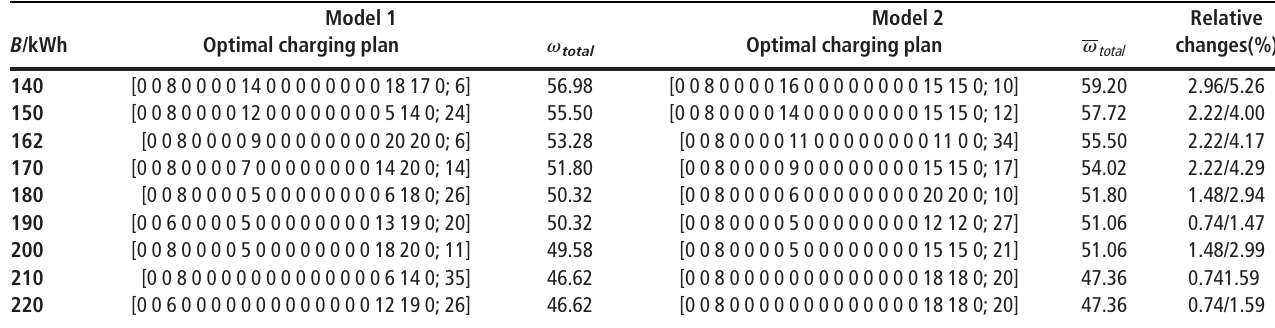
Table 10 Optimal charging plans with different battery capacities